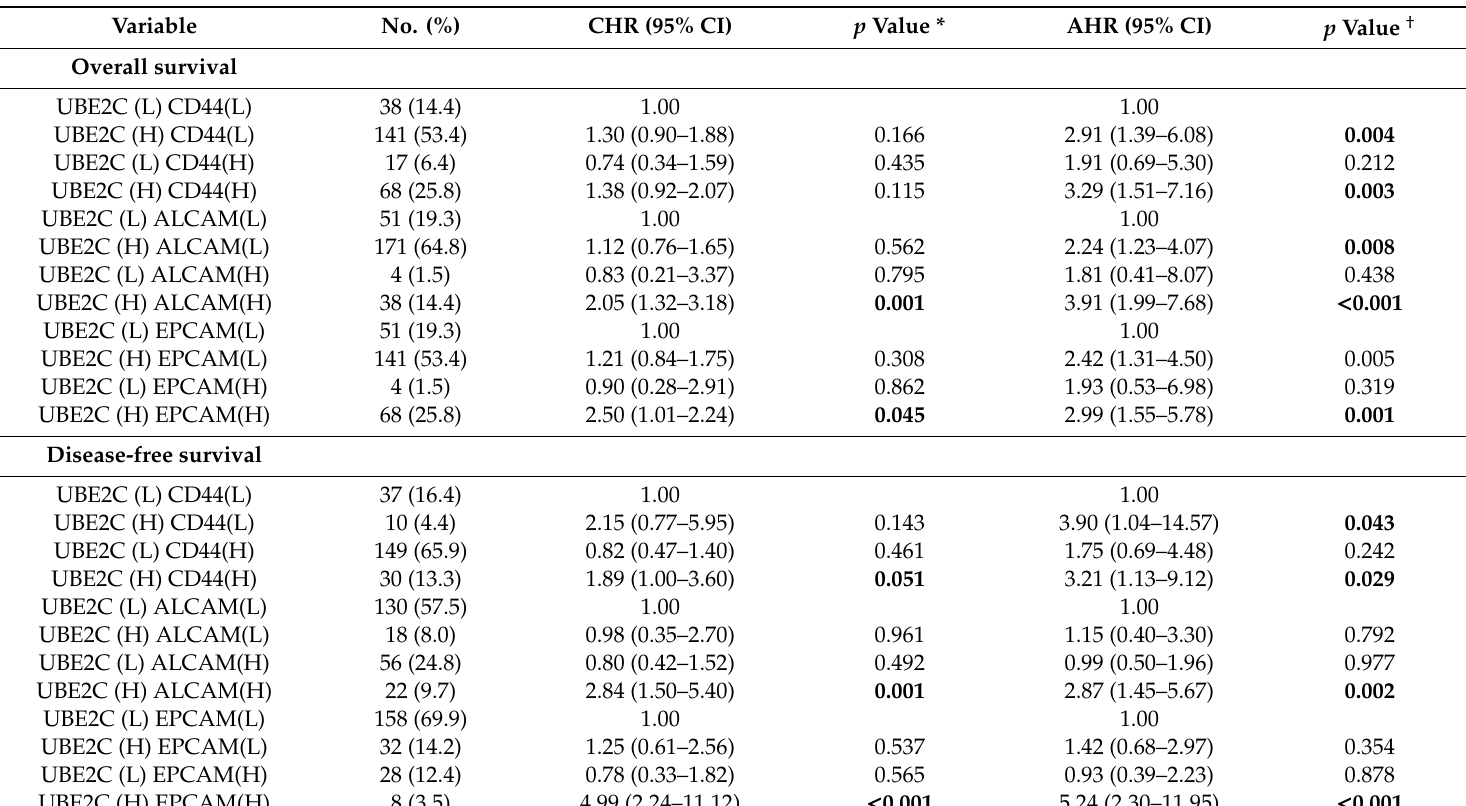
Table 3. Association of co-expression of UBE2C and cancer stemness markers with survival in oral cancer patients from TCGA